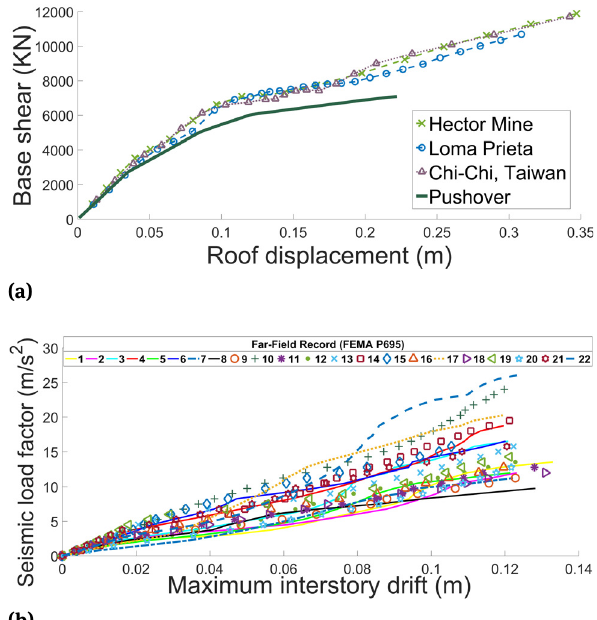
Figure 12: (a) Comparison of IDA and static pushover roof displacement–base shear curve for three-story optimized frame; (b) response of three-story optimized frame.